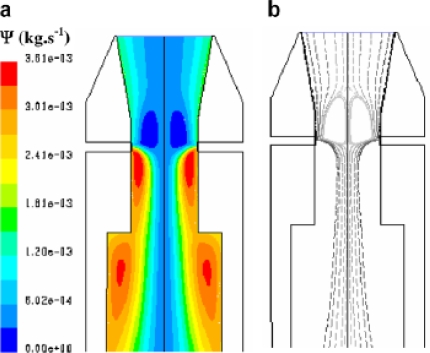
Velocity pattern in the reactor [16].